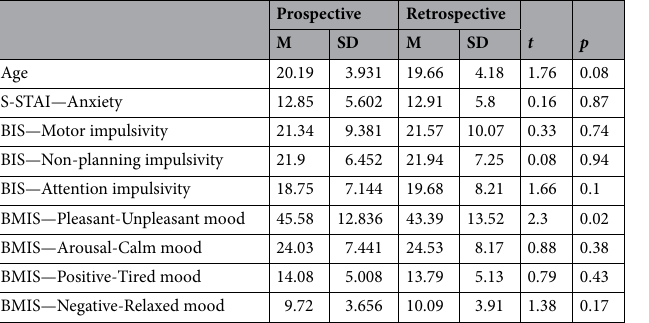
Table 1. Demographic characteristics in the prospective and the retrospective group for the age, the scores on the Short State Anxiety Inventory (S-STAI), the 3 factors of the Barratt Impulsivity Scale (BIS) and the different mood scores of the Brief Mood Introspective Scale